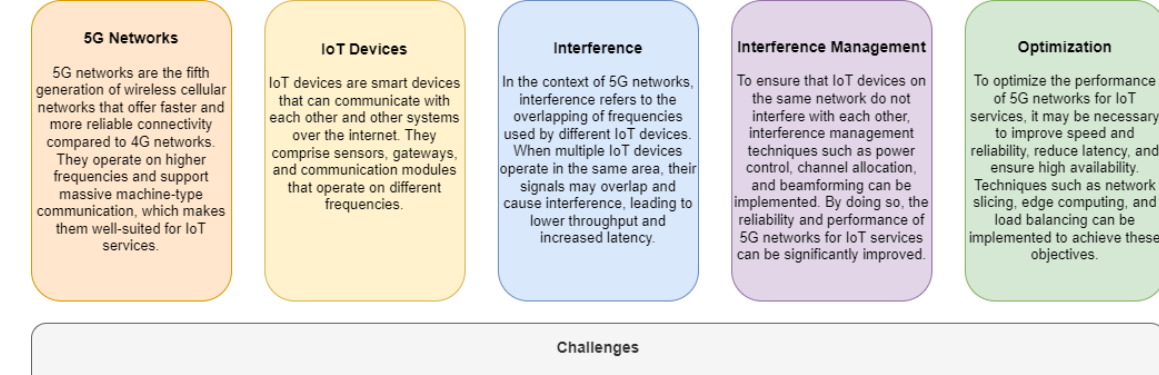
Figure 10. Challenges of 5G